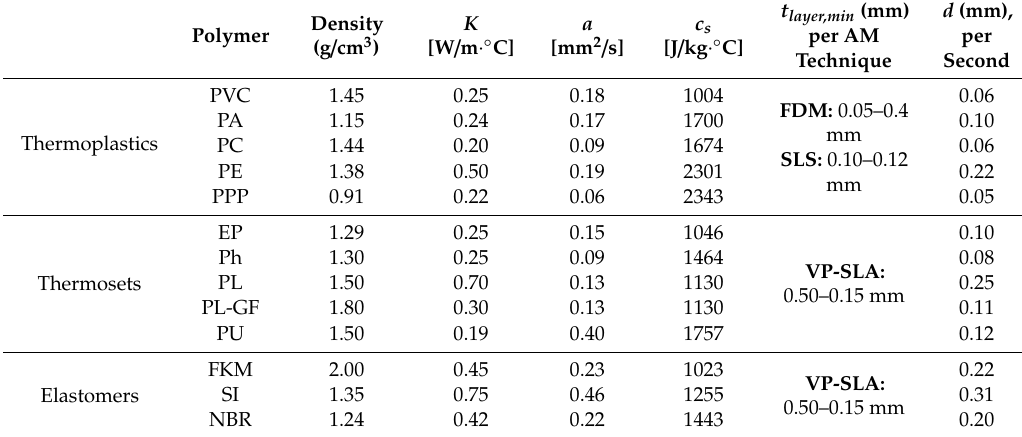
Table 4. Analysis of parameters related to materials processability [48,56–67].